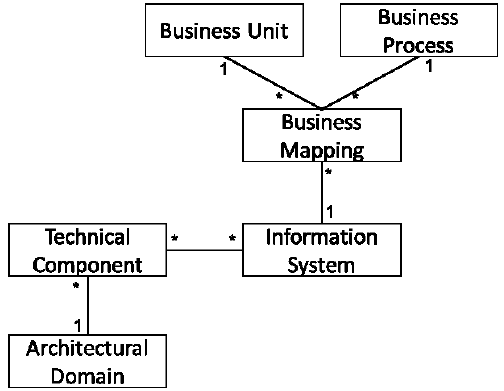
Figure 1. Metamodel of the EA description in our EAM